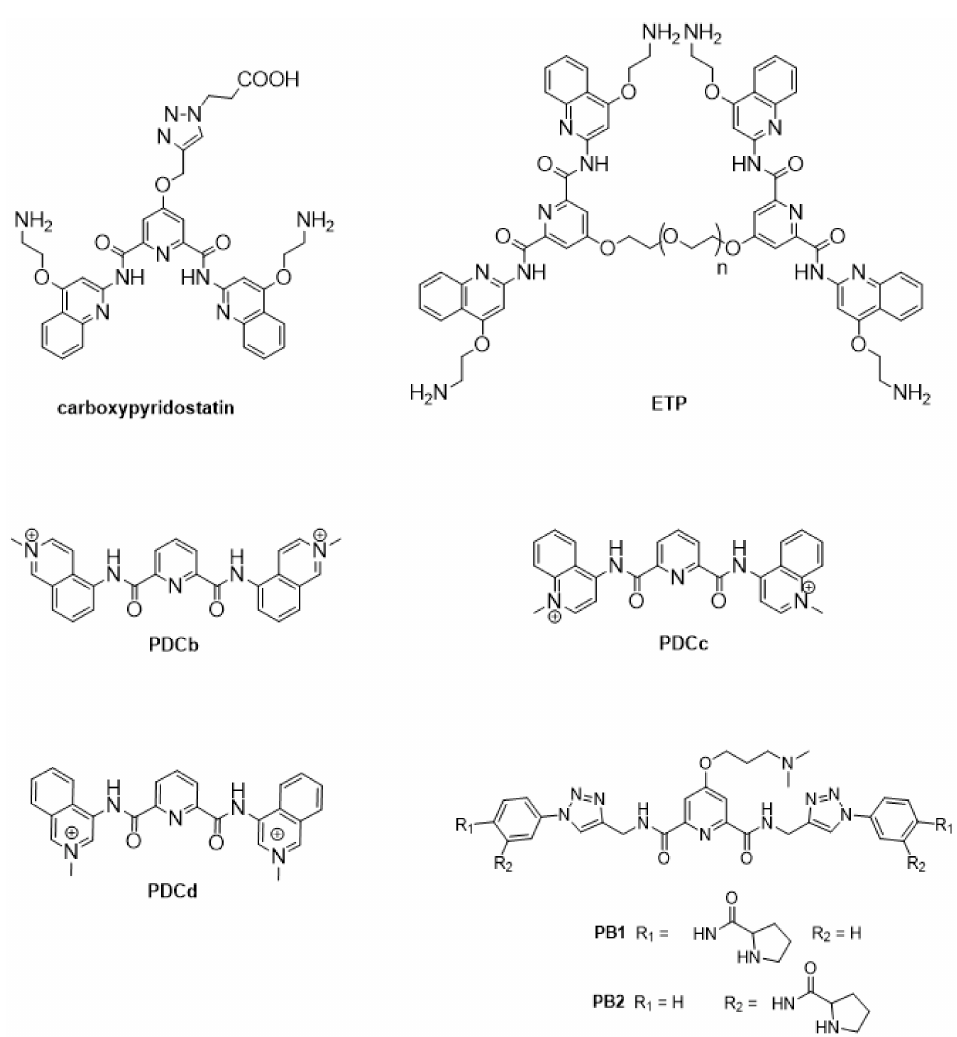
Figure 17. Structures of pyridine-2,6-dicarboxamide